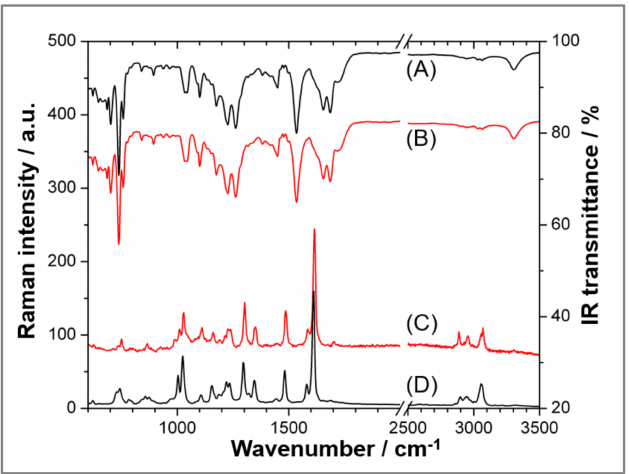
Figure 13. Vibrational spectroscopic analysis of Fmoc-Phe-Gly powder (black traces) and the corre- sponding electrospun fiber (red traces). IR spectrum of (A) powder, (B) fiber, Raman spectrum of (C) fiber and (D) powder. IR was measured in ATR configuration on a diamond prism. Raman scattering was excited at 532 nm. Reproduced from [23] with permission by